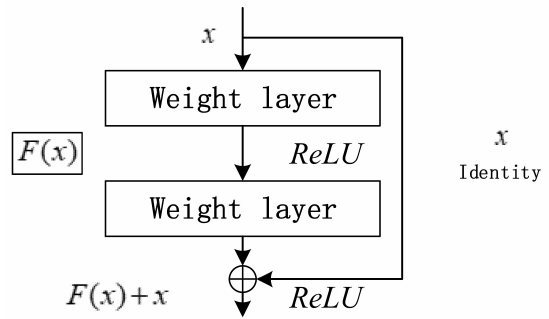
Figure 1. Block diagram of ResNet